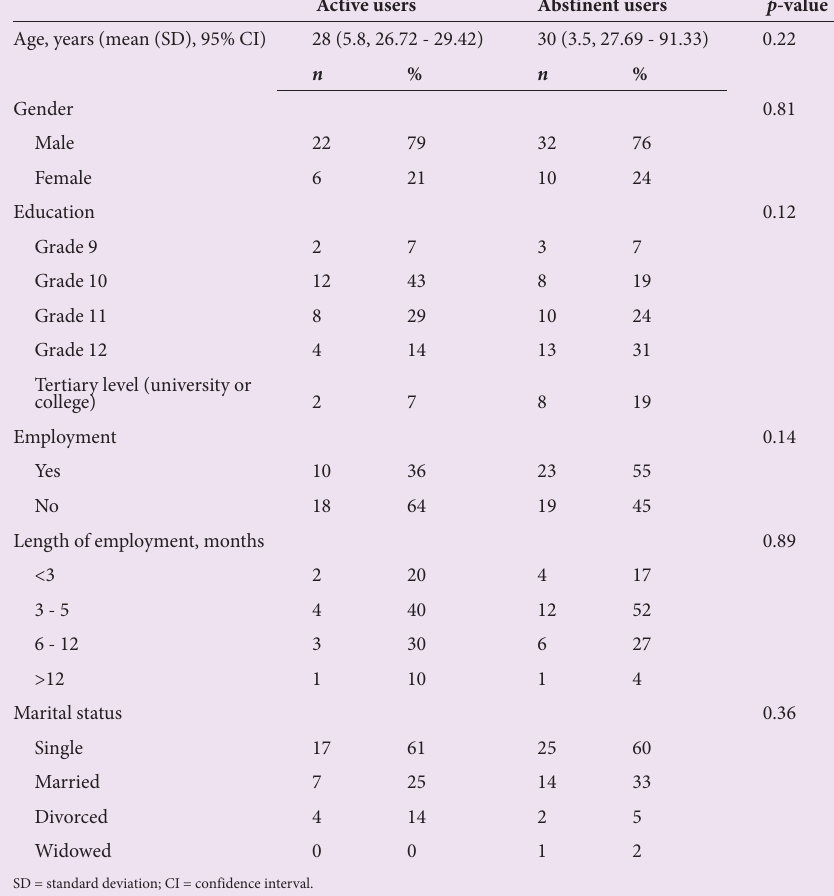
Table 1. Demographic data of active heroin users v. abstinent users 4 years after admis- sion for heroin detoxification at the Opiod Detoxification Unit at Stikland